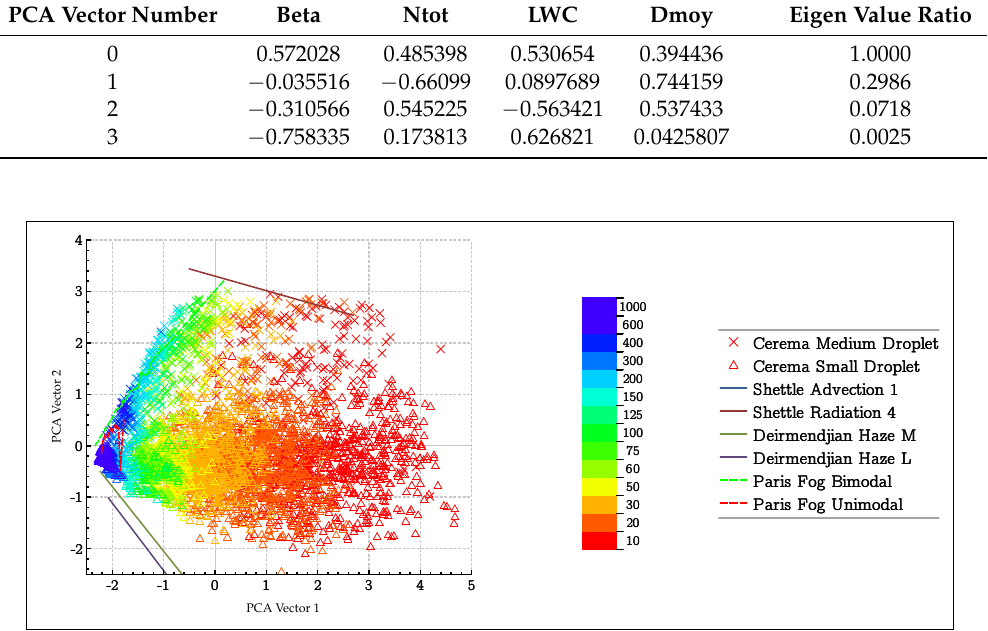
Figure 8. Result of the PCA on conventional parameters for various MOR ranges and different